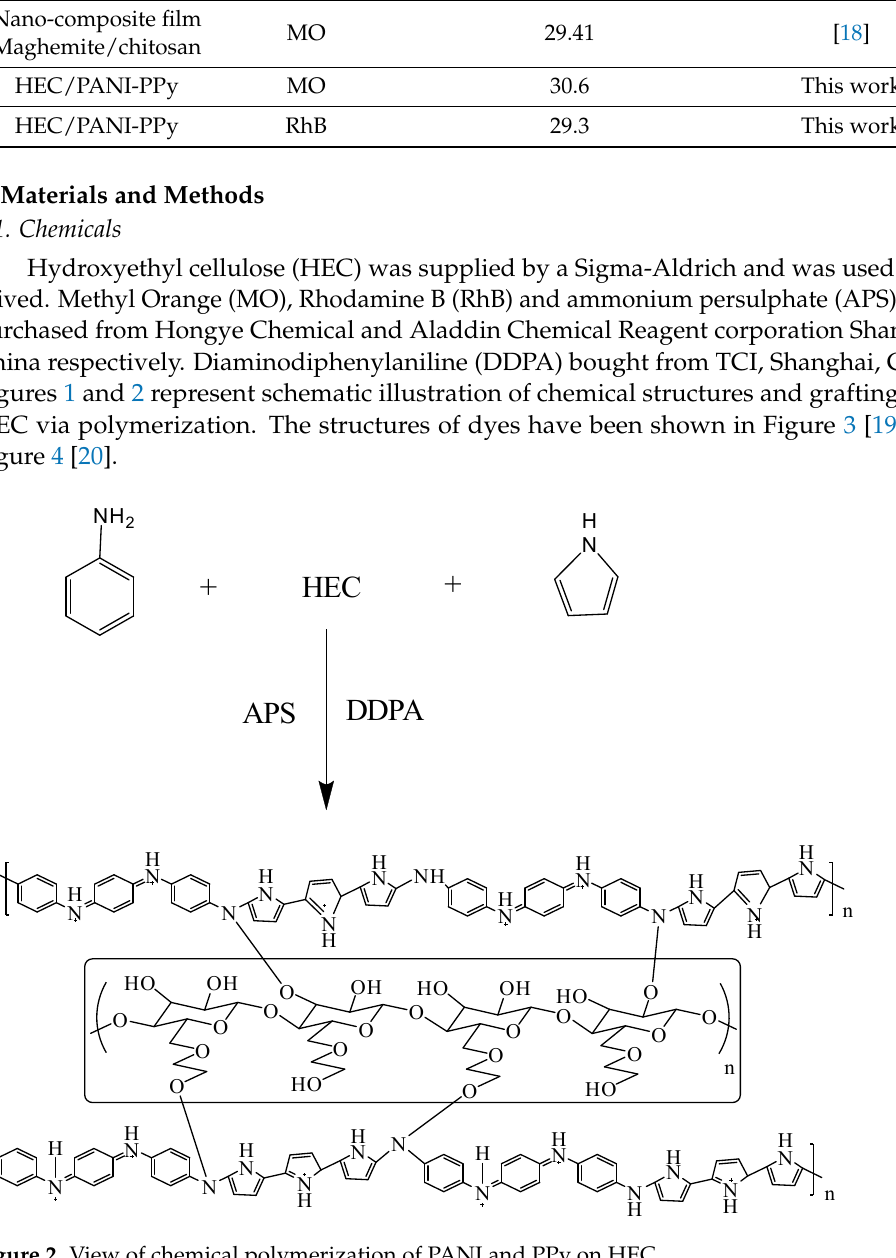
Figure 3. Methyl orange. Figure 4. Rhodamine B. The UV-Visible spectrophotometer (Lambda 25, Perkin Elmer, Shanghai, China) was employed for measuring maximum wavelength λ max and absorbance of dyes samples be- fore and after adsorption.